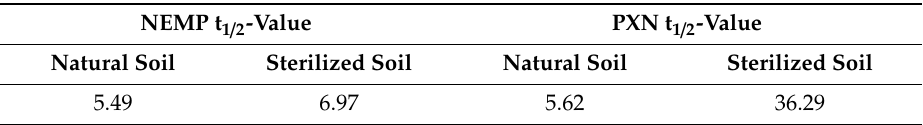
Table 9. Half-life for NEMP and